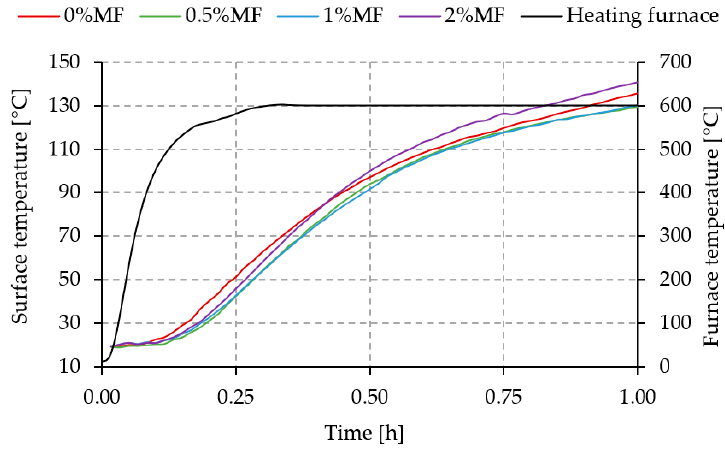
Figure 8. Temperature change depending on the heating time and the melamine content. The green and blue curves corresponding to the composite containing 0.5% and 1% by weight of melamine in relation to the total weight of the geopolymer matrix do not show significant changes in the emission of thermal radiation with increasing temperature in the furnace. Compared to the geopolymer matrix without melamine addition, both curves